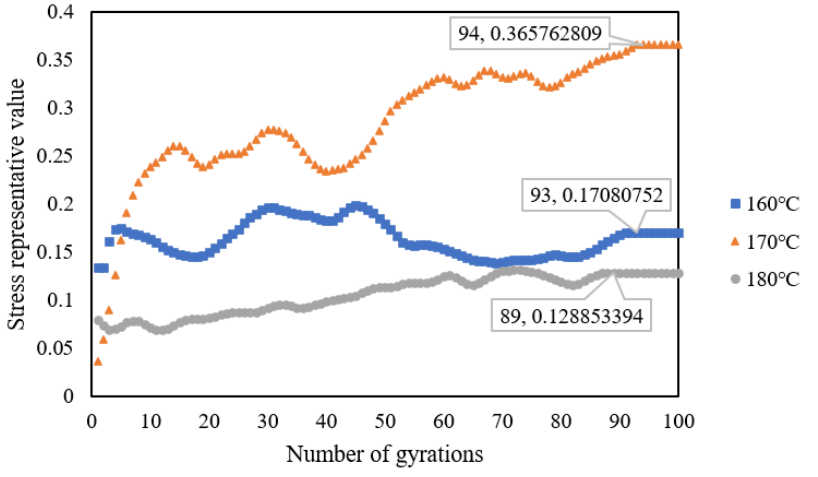
Figure 9. Representative stress values at different compaction temperatures.